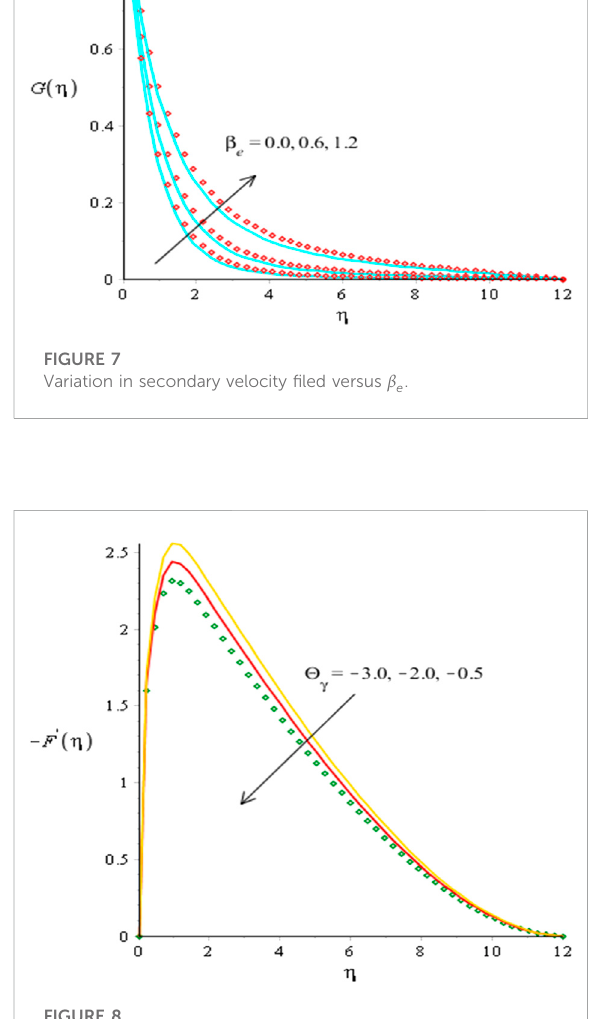
Figure 12 captures the impact of ϵ on thermal pro fi le.